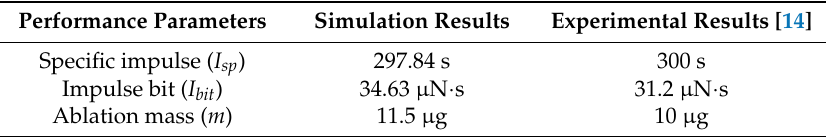
Table 5. Comparison of performance parameters between simulation results and experimental data of the LES-6 PPT in Zhang’s paper